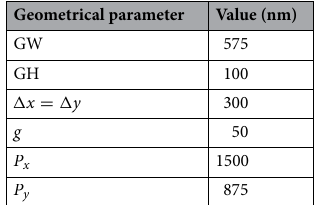
Table 2. Values of the geometrical parameters of the nano-dimer structure, made of GaP.